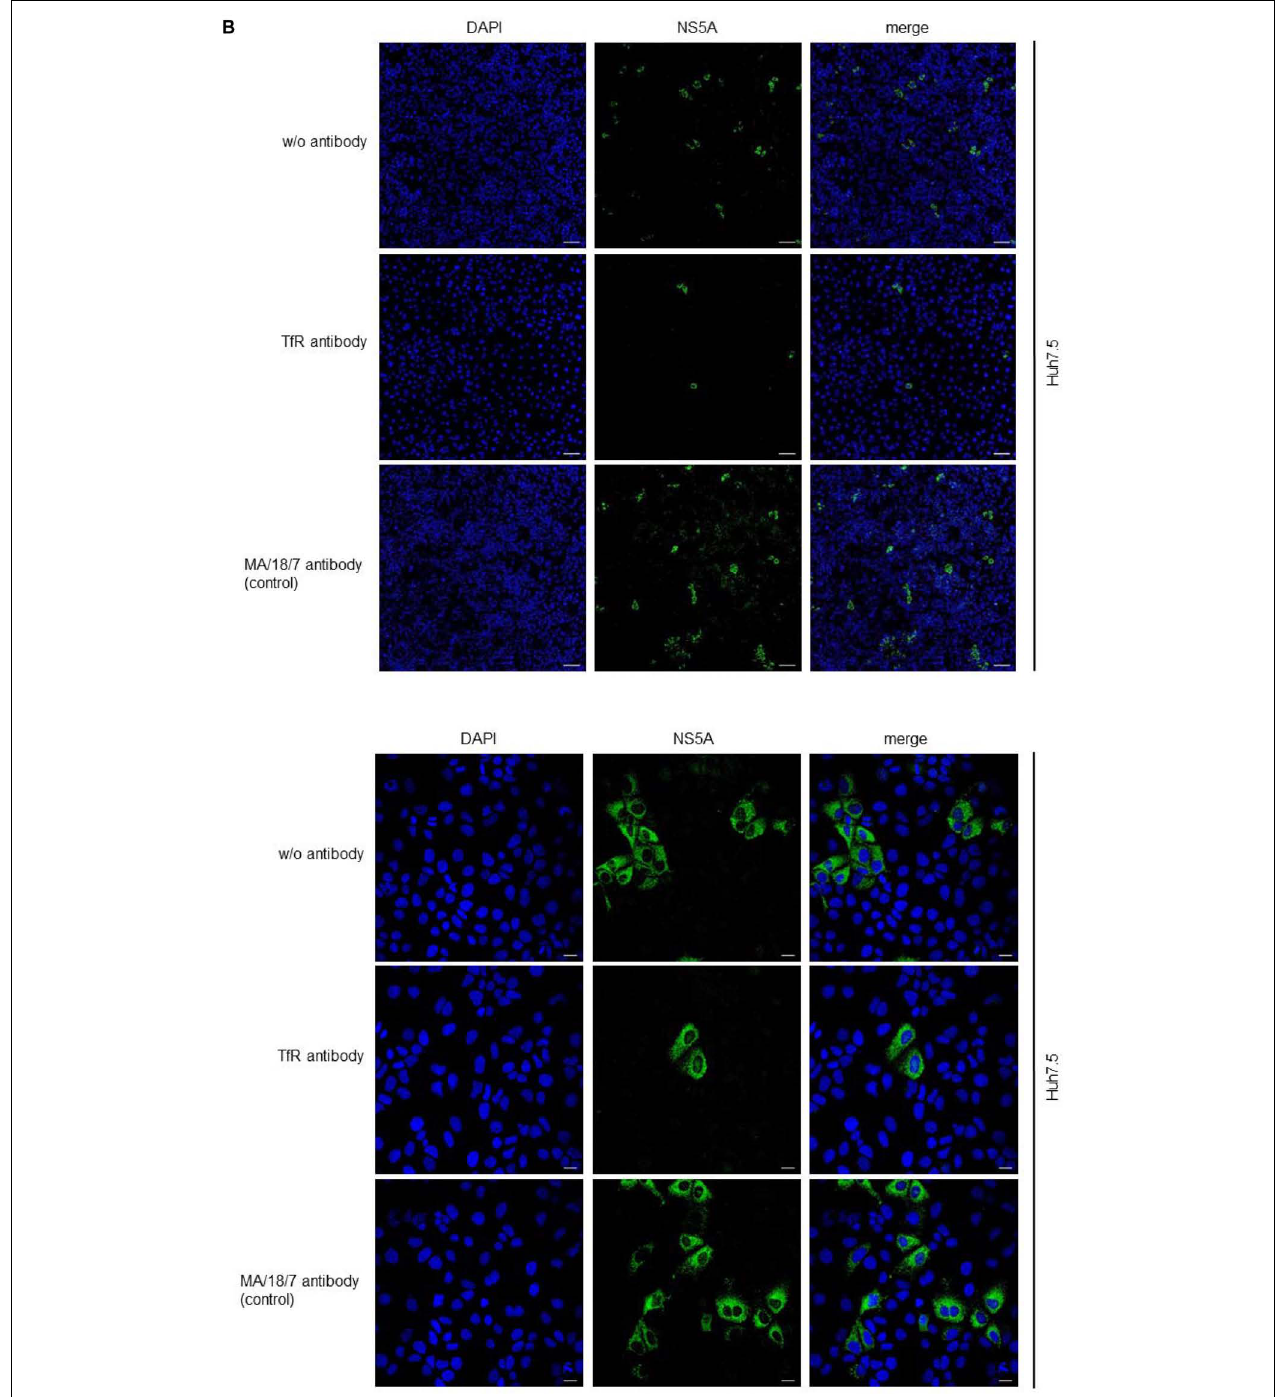
FIGURE 7 | (A) Overexpression of α -taxilin overcomes block of superinfection (Top) CLSM analysis of HCV-positive Huh7.5 cell (Top) or stably α -taxilin overexpressing Huh7.5 cells (Huh7.5-Taxilin) (Bottom), electroporated with the Jc1 E1R construct, encoding for an E1-mCherry fusion protein (red). After 48 h, the cells were co-infected for 48 h with infectious Jc1 5AG supernatant, encoding for a NS5A-eGFP fusion protein (green). Double-positive cells are characterized by a yellow fluorescence signal and visualized by white arrows. Nuclei were stained with DAPI (blue). Laser intensity and digital gain were kept constant for untreated cells. Magnifications, x100. The scale bars represent 10 µ m. (B) Neutralization of HCV infection with infectious supernatant by a TfR-specific antibody binding to the extracellular domain of TfR antibody. Incubation with the HBV-specific antibody MA18/7 served as control. Cells were stained using a NS5A-specific antibody (green). Nuclei were stained with DAPI (blue). Laser intensity and digital gain were kept constant. (Top) Magnifications, x10, the scale bars represent 100 µ m. (Bottom) Magnifications, x40, the scale bars represent 20 µ m.